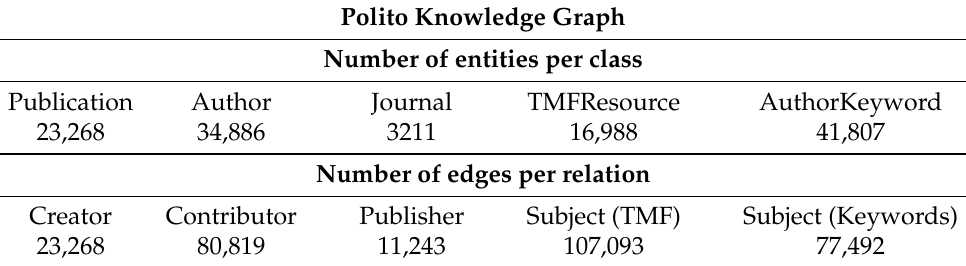
Table 1. Number of entities and edges in the Polito Knowledge